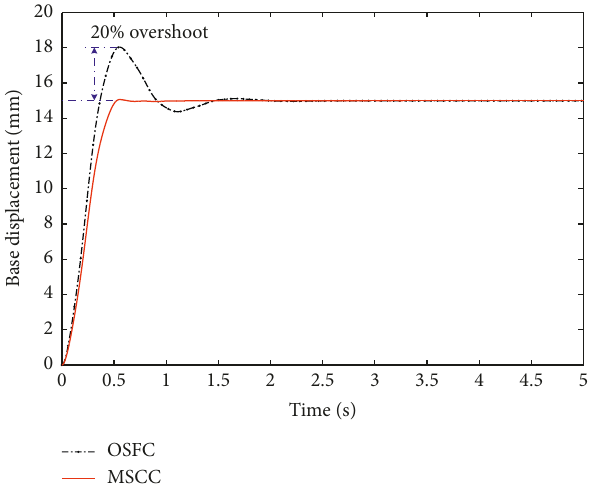
Figure 10: Control effects of the master-slave composite controller on the base displacement.